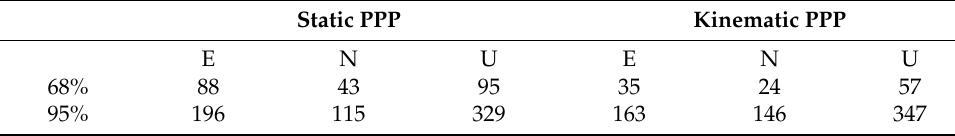
Table 9. Convergence time of the EG method (unit: min) (R/E).